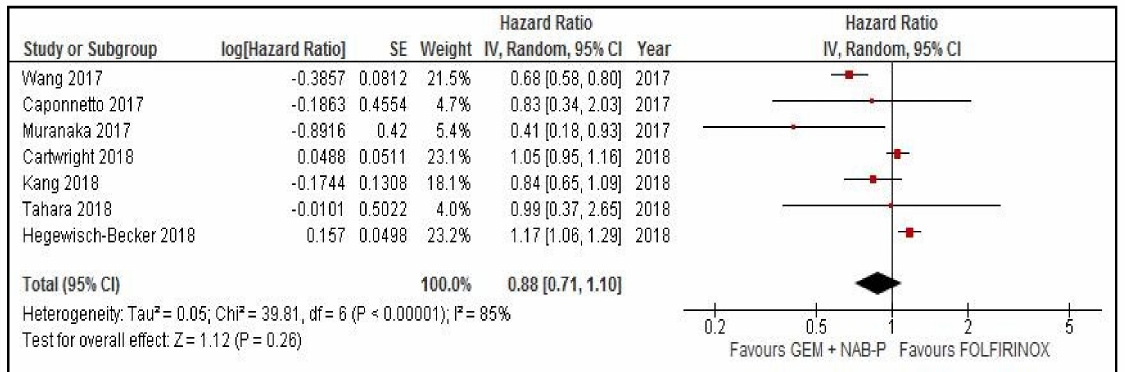
Figure 1. Overall survival comparison between gemcitabine plus nab paclitaxel and FOLFIRINOX. CI: confidence interval, GEM + NAB-P: gemcitabine plus nab paclitaxel, IV: interval variable, SE: standard error.